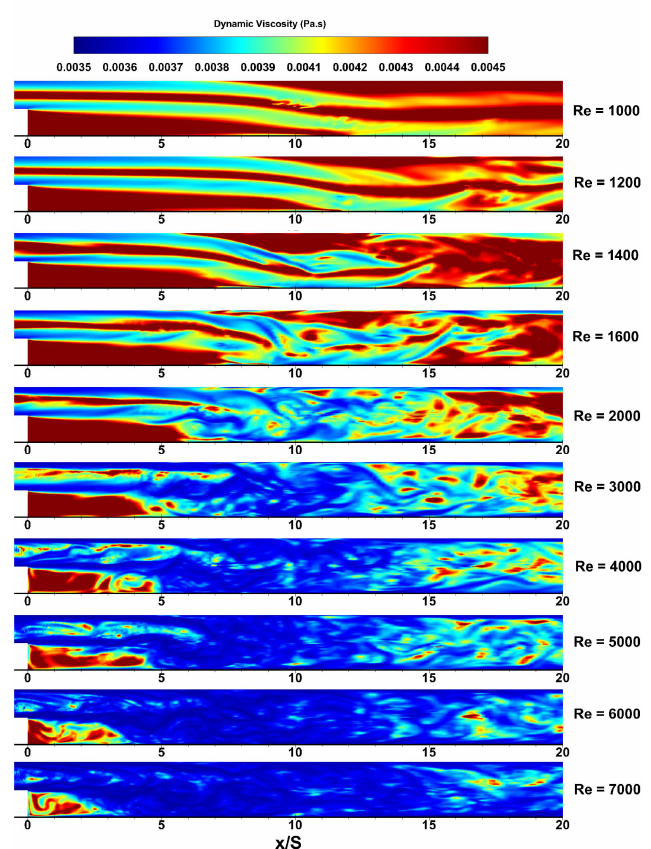
Figure 16. Instantaneous dynamic viscosity contour plots for shear-thinning blood rheology for Re =